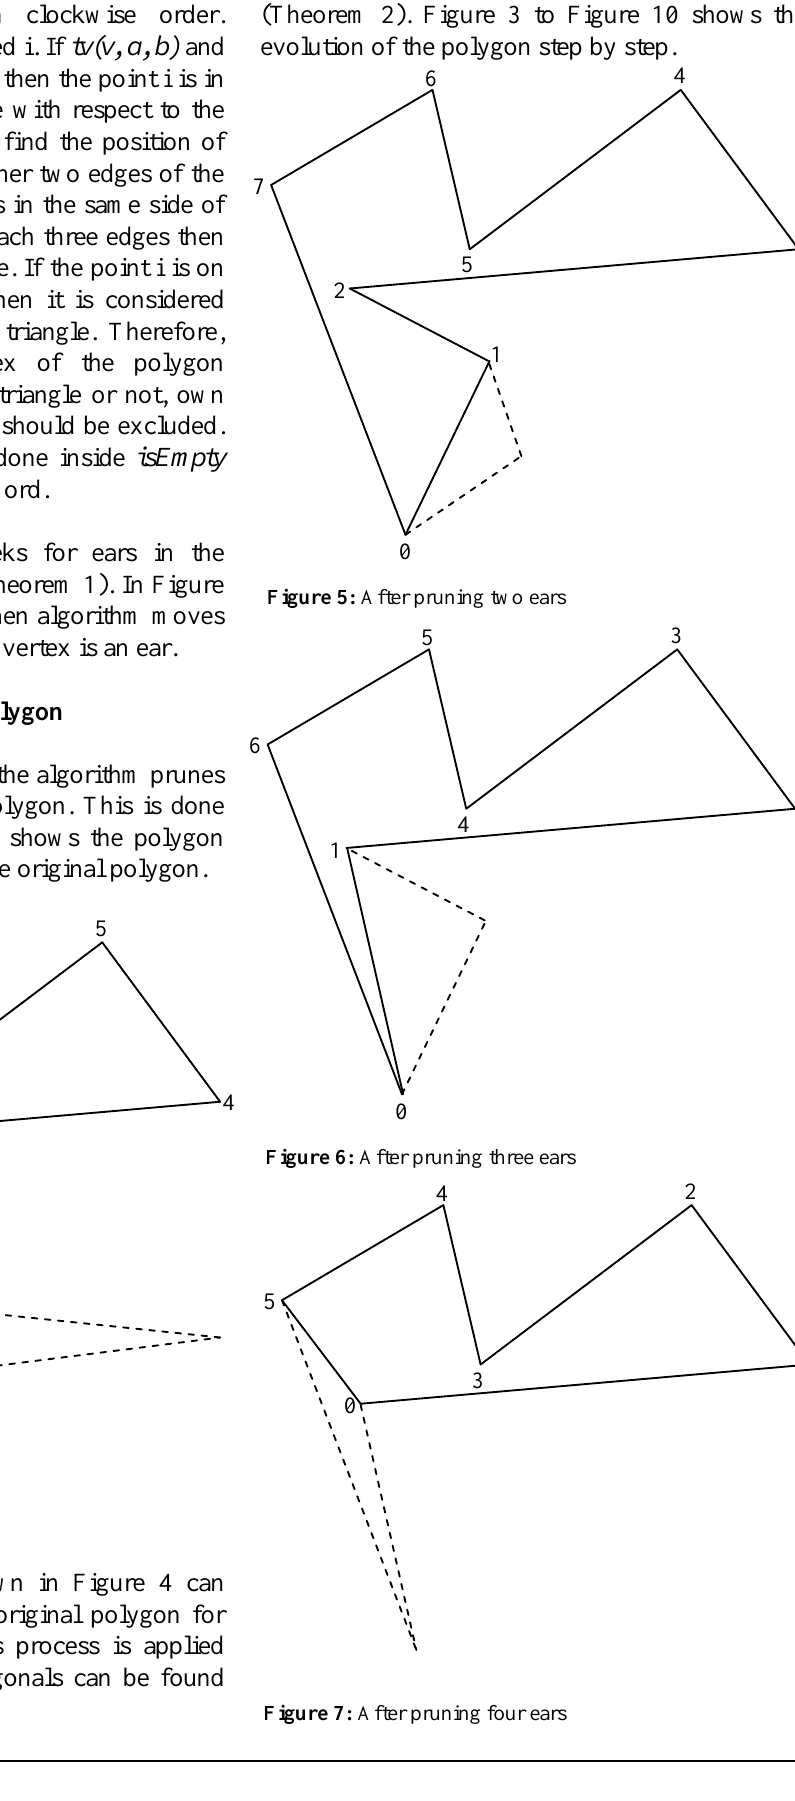
Figure 7: After pruning four